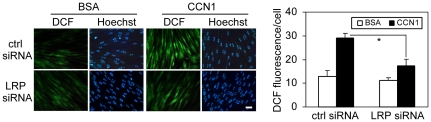
LRP1 mediates CCN1-induced ROS production.
A. HSFs transfected with 80 nM non-targeting control siRNA or siRNA against LRP1, were used 72 hrs post-transfection for measurement of CCN1-induced ROS by fluorescence microscopy. Cells were loaded with 10 µM CM-H2DCF-DA and treated with (2 µg/ml) CCN1 for 15 mins. After nuclear counterstaining with Hoechst 33342 dye, multiple areas of the wells were photographed (left panel) and green fluorescence (DCF) was quantified as described in materials and methods (right panel: *p<0.05, n = 3).